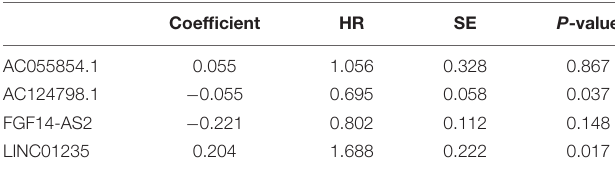
TABLE 6 | Multivariate cox regression analysis of FGF14-AS2, LINC01235, AC055854.1, and AC124798.1 associated with survival in breast cancer